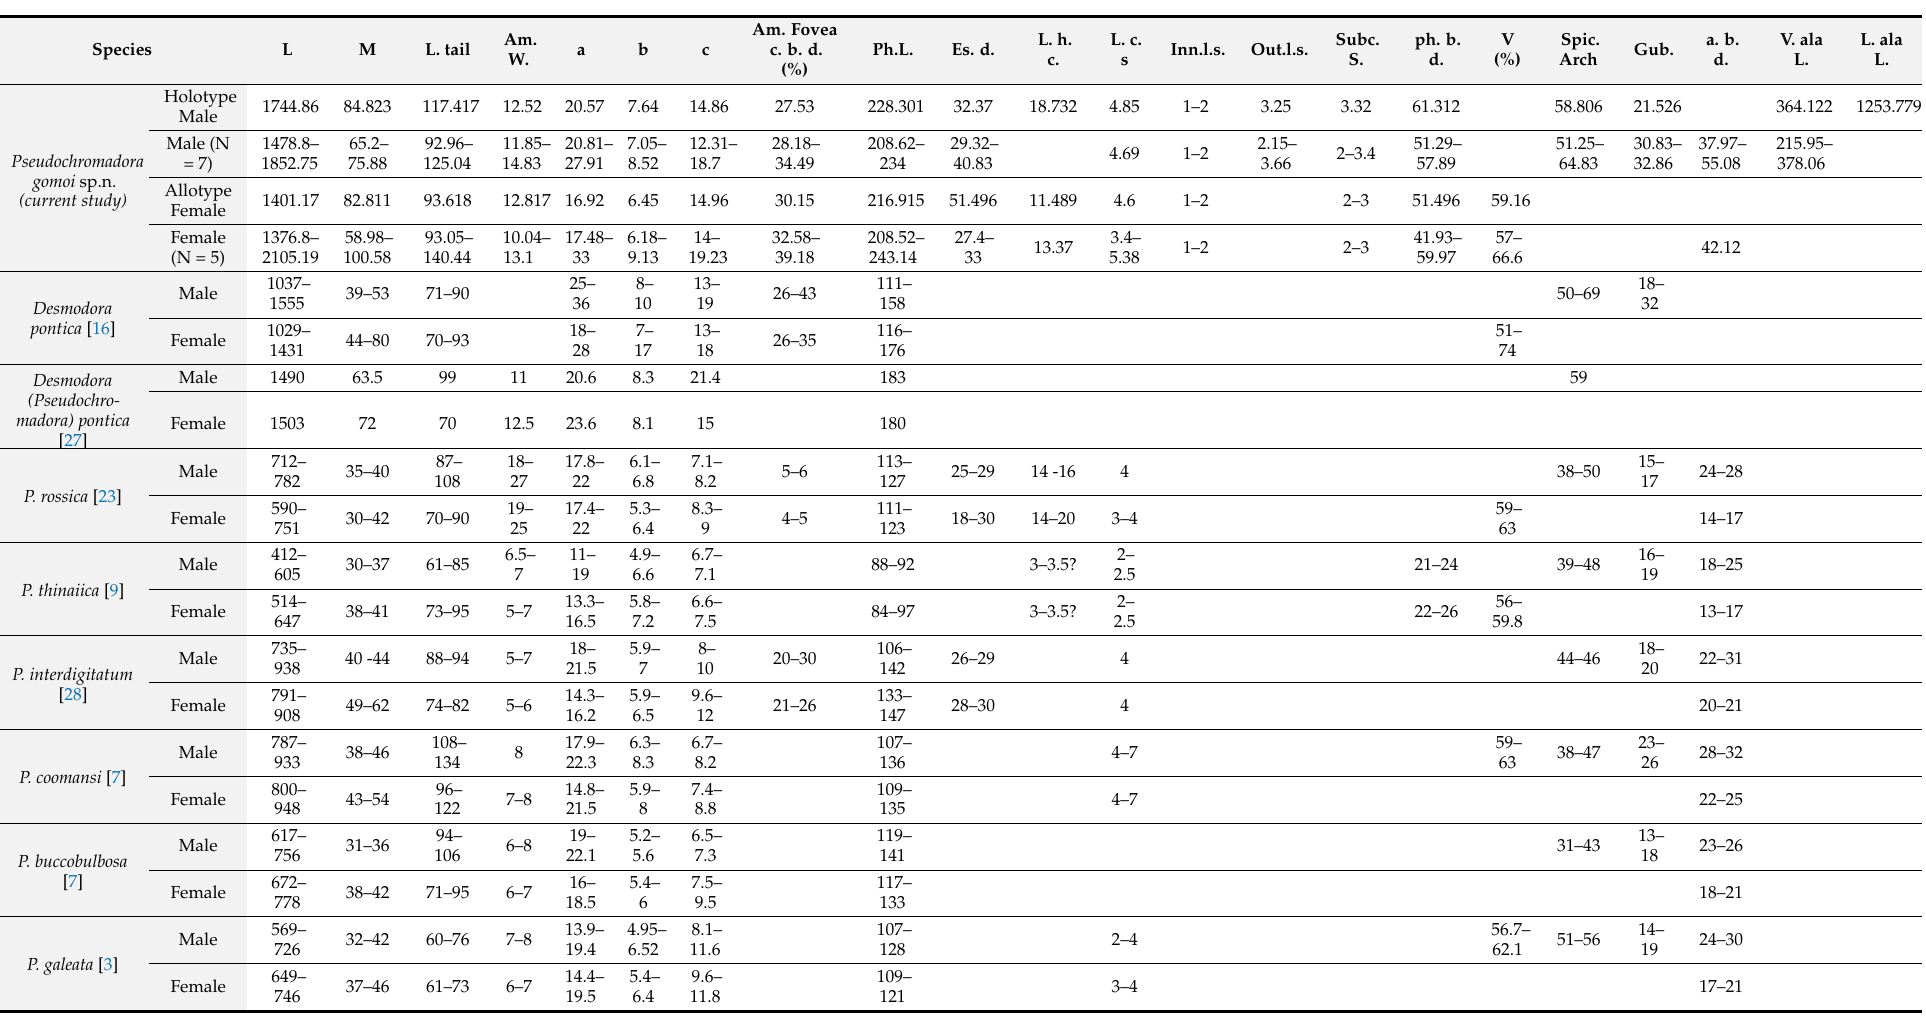
Table 1. Morphometrics of Pseudochromadora gomoi sp.n. and other Desmodoridae species based on literature. Data are presented as minimum–maximum values. All measurements are given in µ